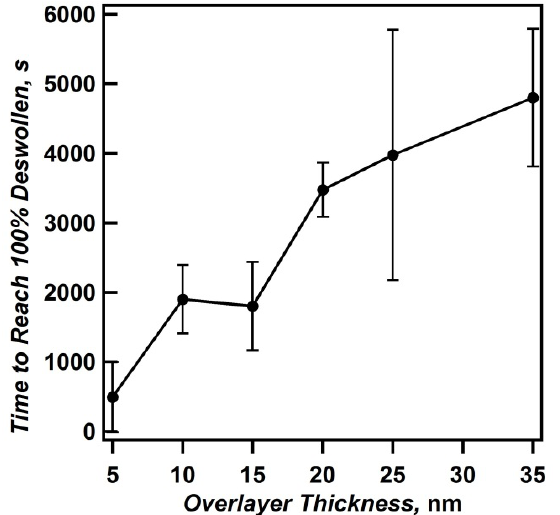
Figure 6. The time required for etalons of various overlayer thicknesses to reach 100% deswollen. Error bars are the standard deviations for the averages from two different sets of independently fabricated samples. Reprinted with permission from [14] Copyright (2011) American Chemical